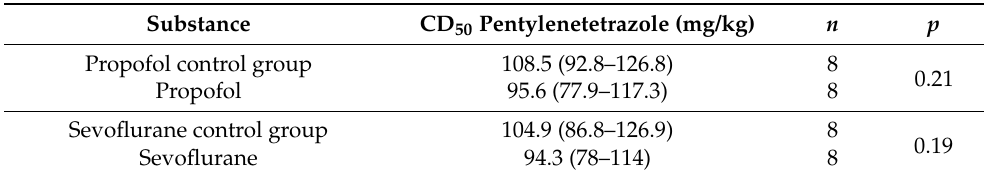
Table 2. Influence of propofol and sevoflurane administration during synaptogenesis on seizure threshold in pentylene-tetrazole model in adult rats.